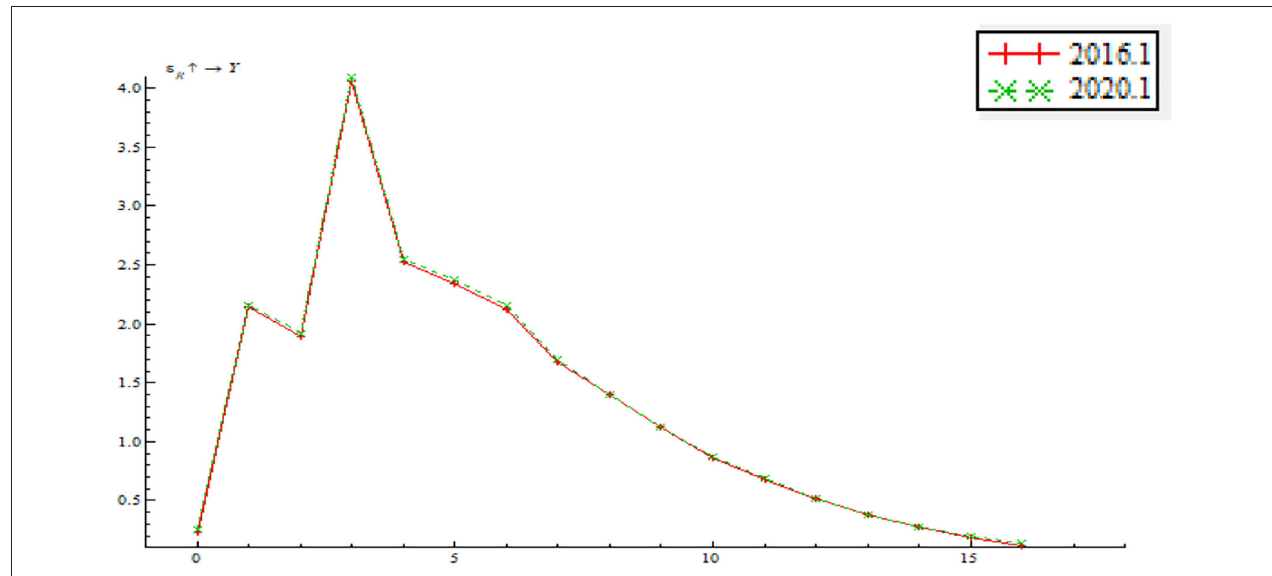
FIGURE 14 | Time point-based shock of price-based monetary policy on output gap.